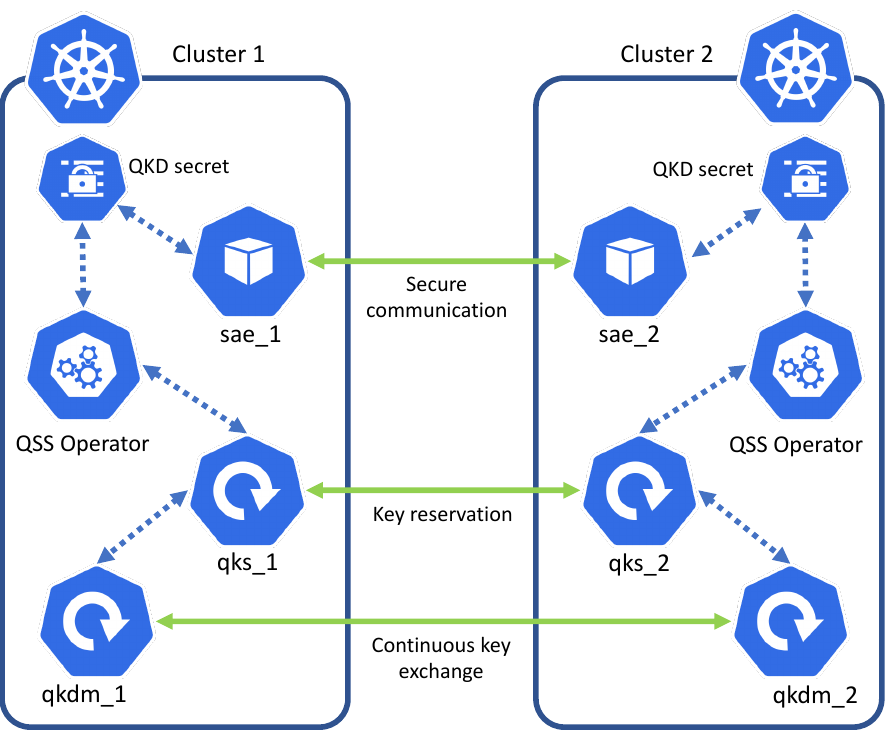
Figure 3. PTP exchange among clusters.